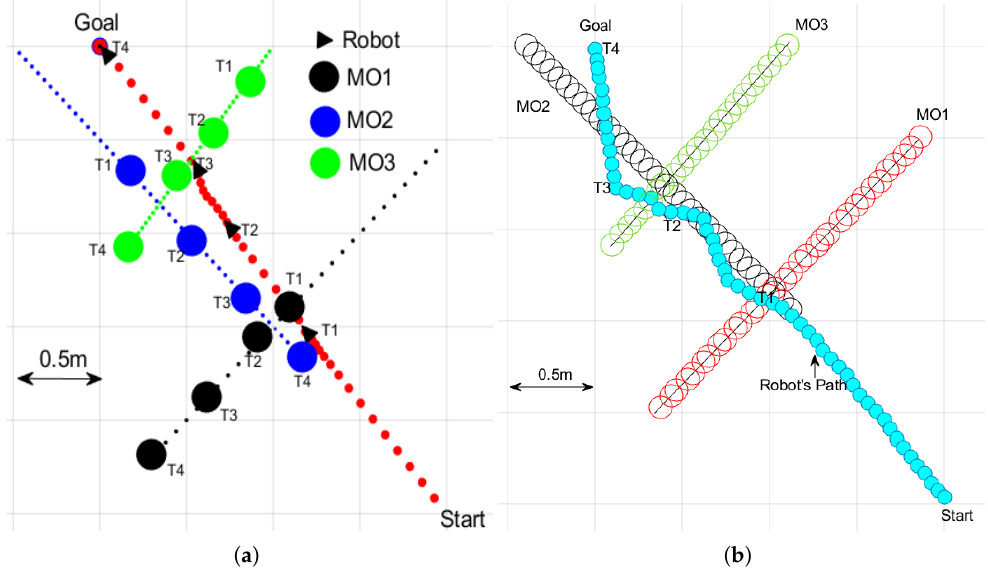
Figure 12. The ANADE and MBCGA. The robot’s and obstacles’ locations at four different time instants, T1–T4. ( a ) The robot’s path with the ANADE. ( b ) The robot’s path with the